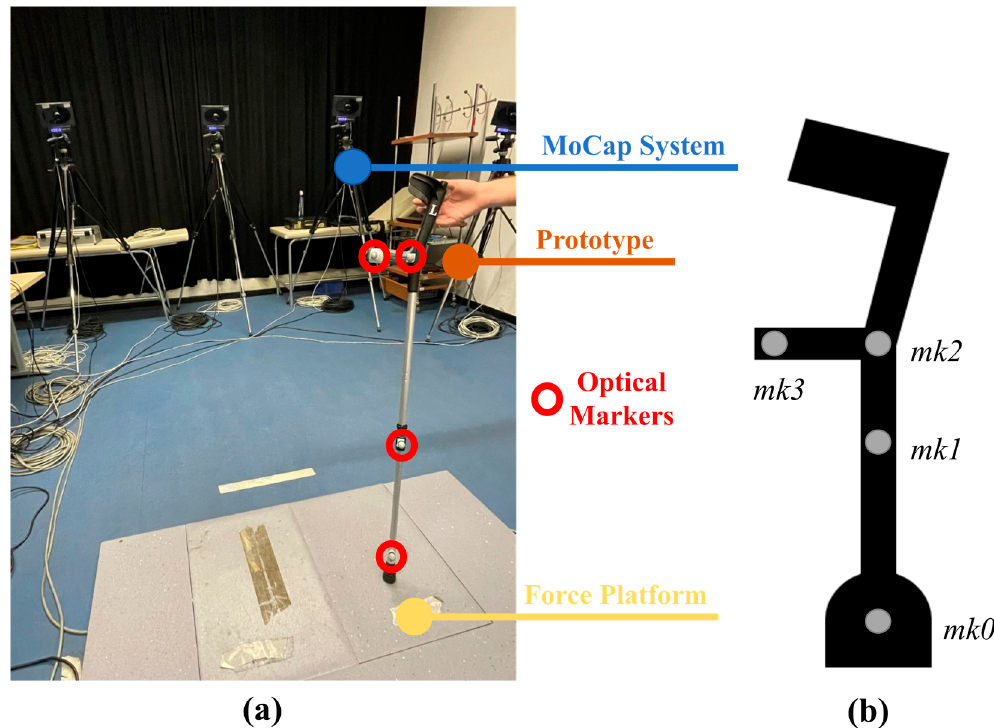
Figure 8. Calibration setup: laboratory environment ( a ) and marker positioning ( b